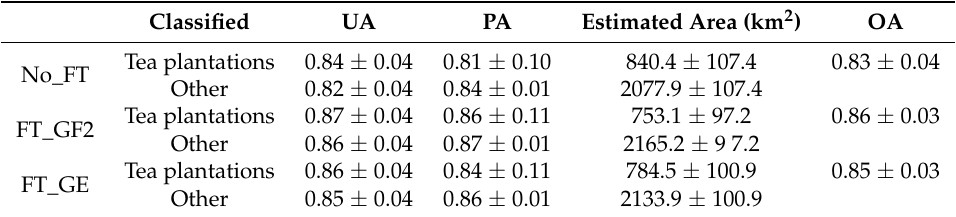
Table 3. Confusion matrix of tea plantation results on GF-2 images by the No_FT, FT_GF2, and FT_GE. UA, PA, and OA refer to user accuracy, producer accuracy, and overall accuracy, respectively. 95% confidence